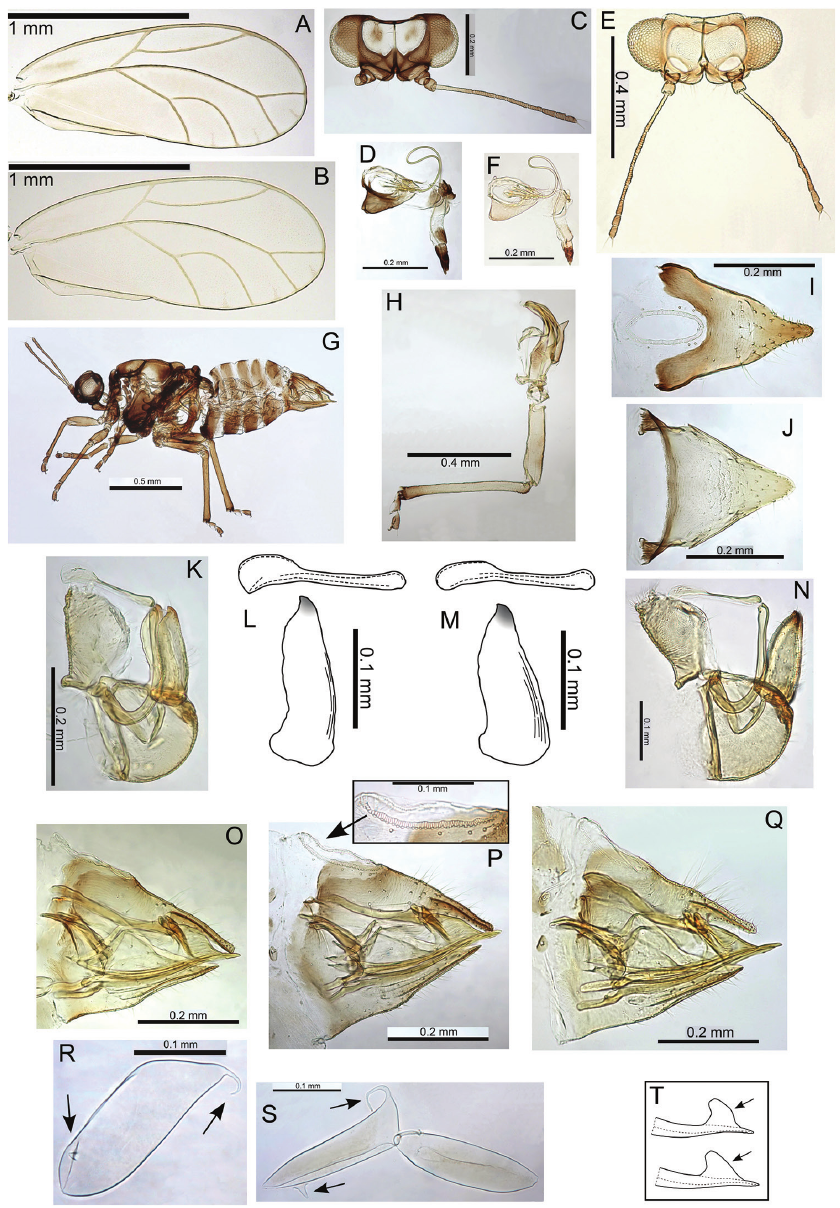
Figure 19. Pariaconus minutus . A, B fore wing: A form minutus B form kilaueaiensis C, D form minu- tus : C head and antenna D proboscis E, F form kilaueaiensis : E head and antenna F proboscis G female H hind leg I female proctiger (dorsal view) J female subgenital plate (ventral view) K, L form minutus : K male terminalia L aedeagus and paramere M, N form kilaueaiensis : M aedeagus and paramere N male terminalia O, P female terminalia, form minutus : O (Olaa, Hawaii) P (Saddle Rd., Hawaii) Q female terminalia, form kilaueaiensis R, S eggs (pedicel and tail indicated): R form minutus S form kilaueaiensis T ovipositors (shape variation indicated), form minutus (above) form kilaueaiensis